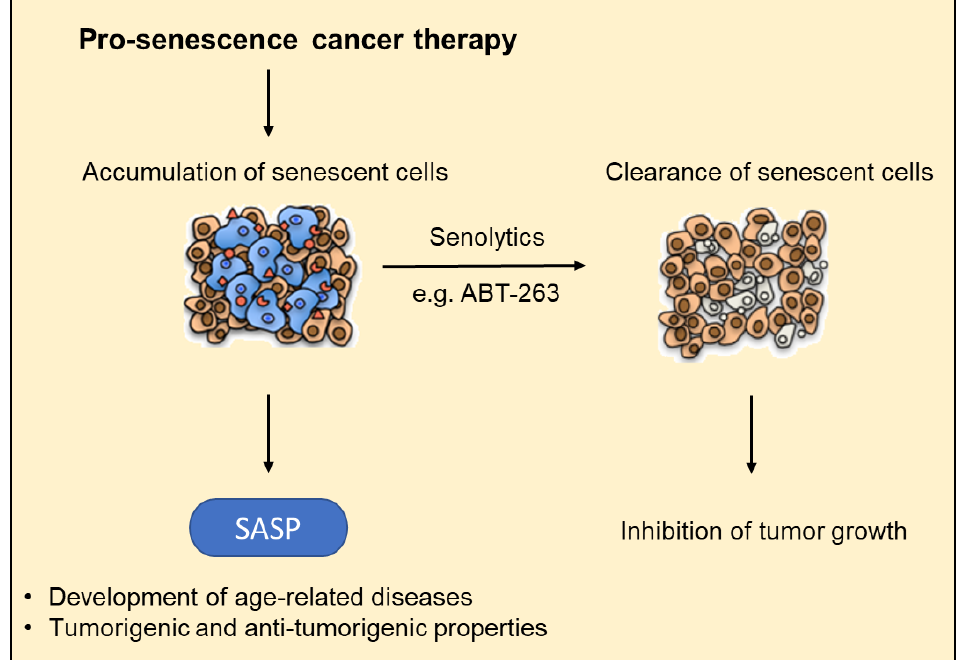
Figure 2. Pro-senescence cancer therapies to combat tumor growth. The accumulation of senescent cells in different tissues due to a reduced clearance as a result of, e.g. a compromised immune system leads to an increase in SASP factor secretion. This favors the development of age-related diseases and may counteract antitumor effects. The combination with senolytics may prevent an accumulation of senescent cells and the resulting deleterious effects of the SASP.